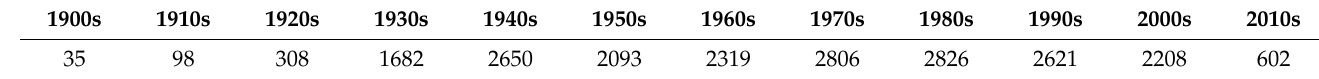
Table 3. Number of yearbook photos for each